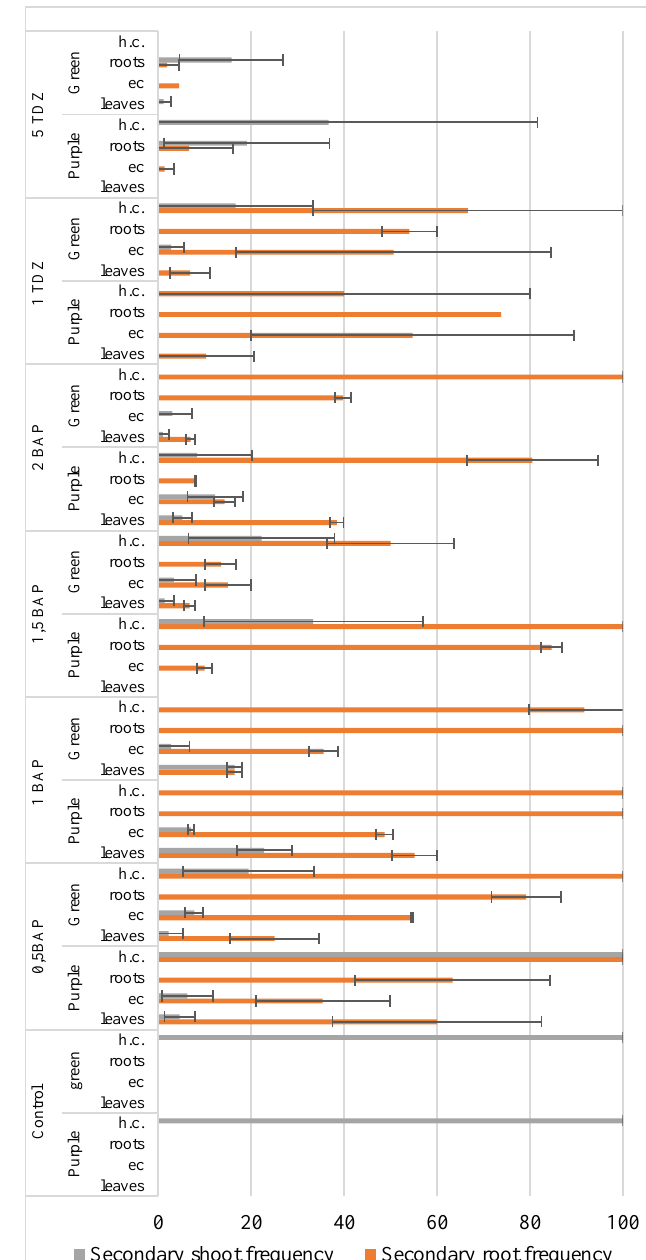
Figure 5. The secondary root and shoot frequency of different explants of different O. basilicum varieties. h.c: hypocotyl, e.c: